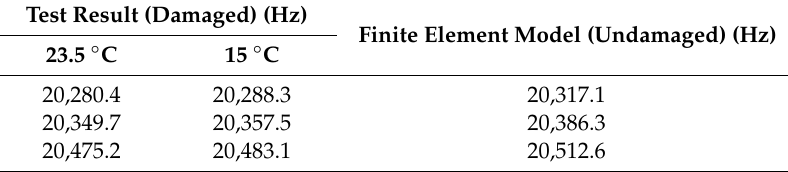
Table 5. Frequency of the first three resonance peaks with temperature